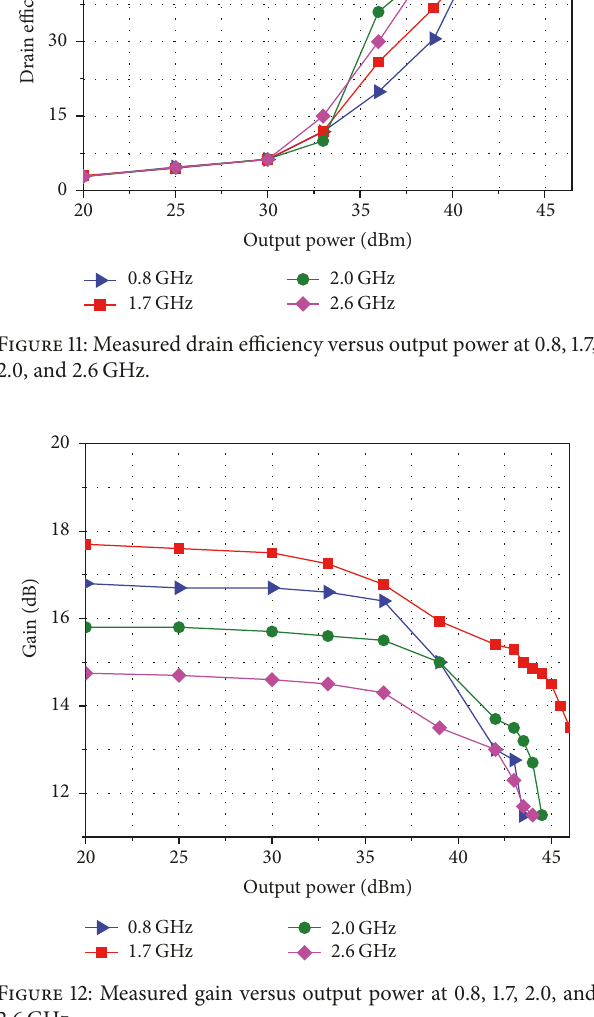
increase of output power as depicted in Figure 11. High drain efficiency can be obtained at high output power.